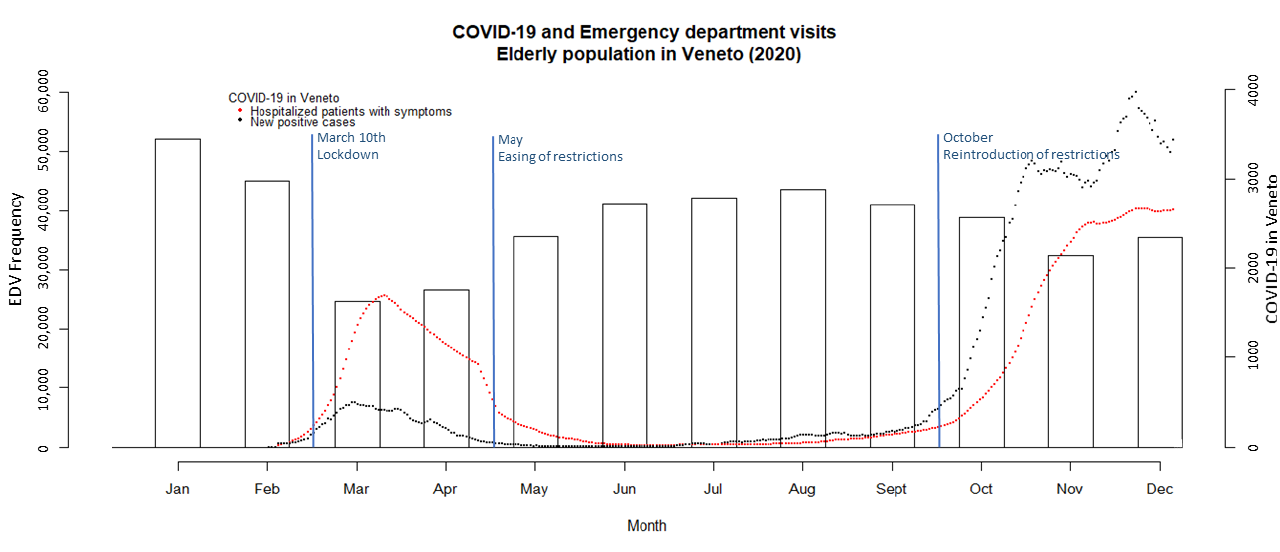
Figure 1. Trend of COVID-19 pandemic and emergency department visits in 2020 in Veneto (Italy). The number of ED visits is shown on the y-axis (left), and its monthly trend is represented by the vertical bars (histogram); the number of new COVID-19 cases and hospitalizations of patients with symptoms of COVID-19 is shown on the right y-axis, and their trends over time are represented by black and red dots, respectively.